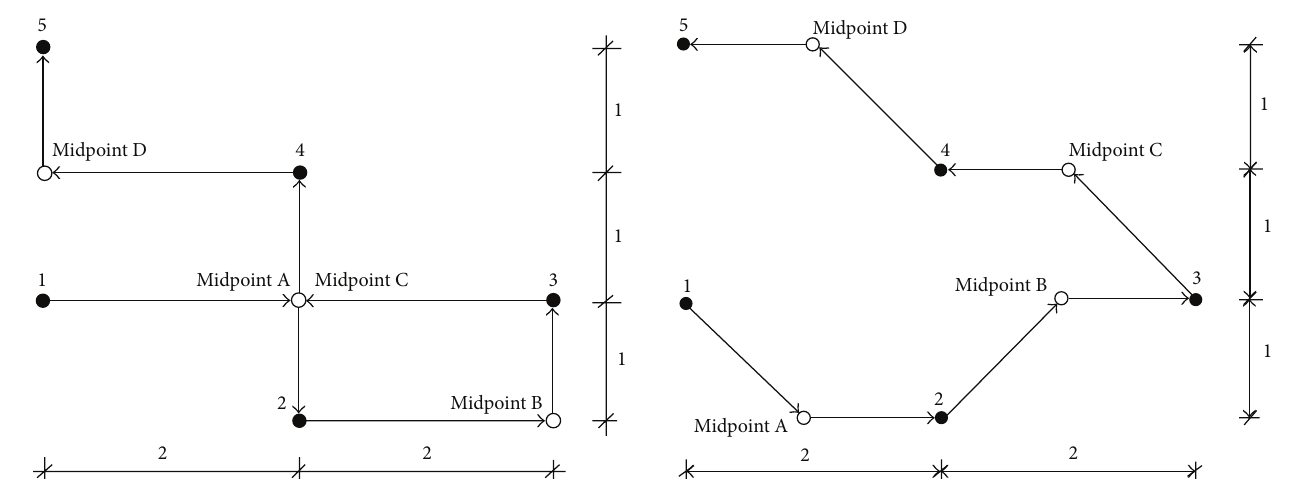
Figure 1: Worktable movements for Case 1. Figure 2: Worktable movements for Case 2.